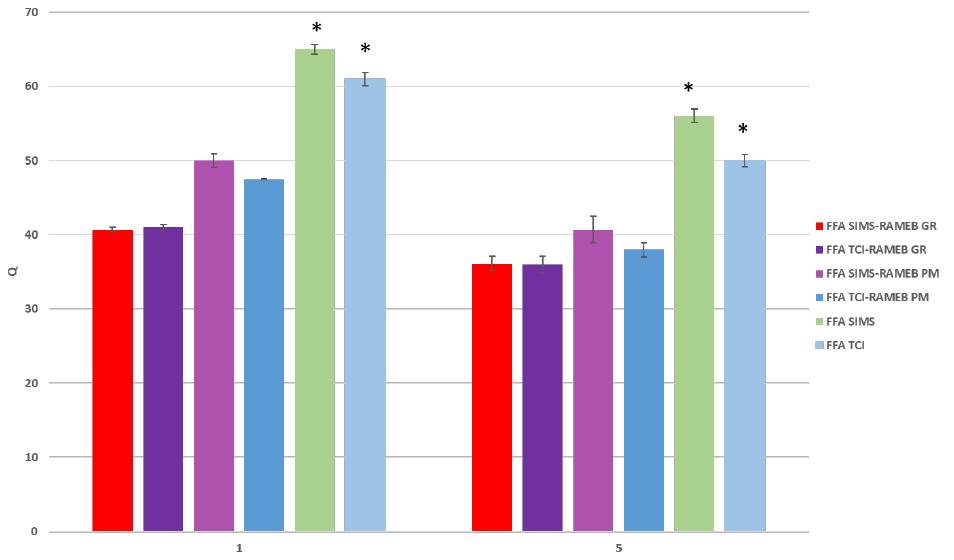
Figure 5. Contact angles (Q) between a water droplet and the surface of the different conventional tablets for enteric coating (CT) containing the drug, provided by TCI or SIMS, as such or as physical mixture (PM) or co-ground product (GR) with RAMEB, at 1 and 5 min after the droplet deposition (mean of 3 determinations). * p < 0.05.